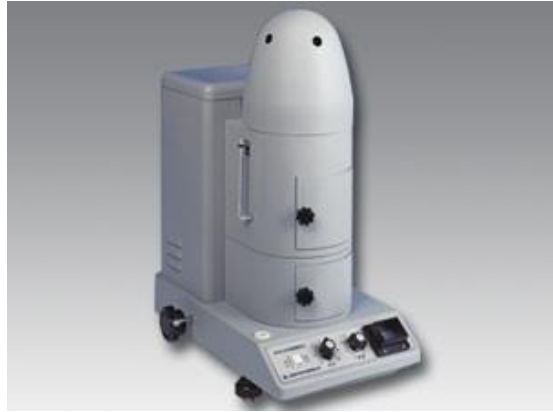
Figure 3. The rapid moisture meter.